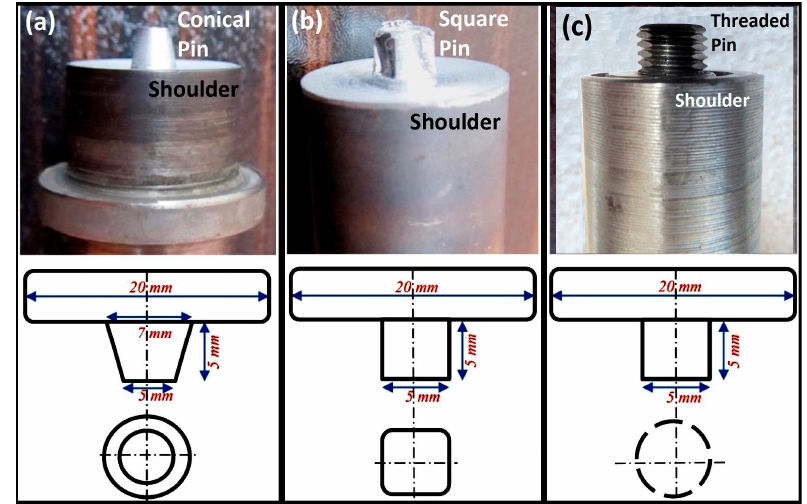
Table 2. The operational welding parameters of the friction stir welding (FSW) process for the AA1100 plates.